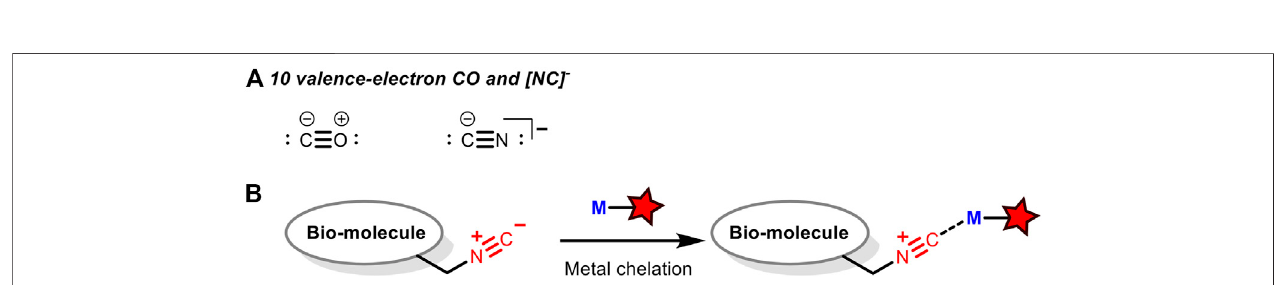
FIGURE 8 | (A) 10 valence-electron CO and [NC] − that function as terminal ligands to transition metals. (B) Isocyano-containing biomolecules can be labelled via metal chelation. M (cid:2) transition metal.